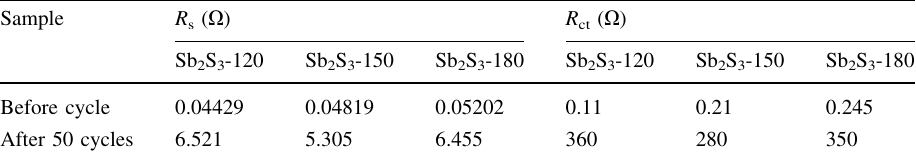
2 S 3 -120, Sb 2 S 3 -150, and Sb 2 S 3 -180 electrodes in NIBs